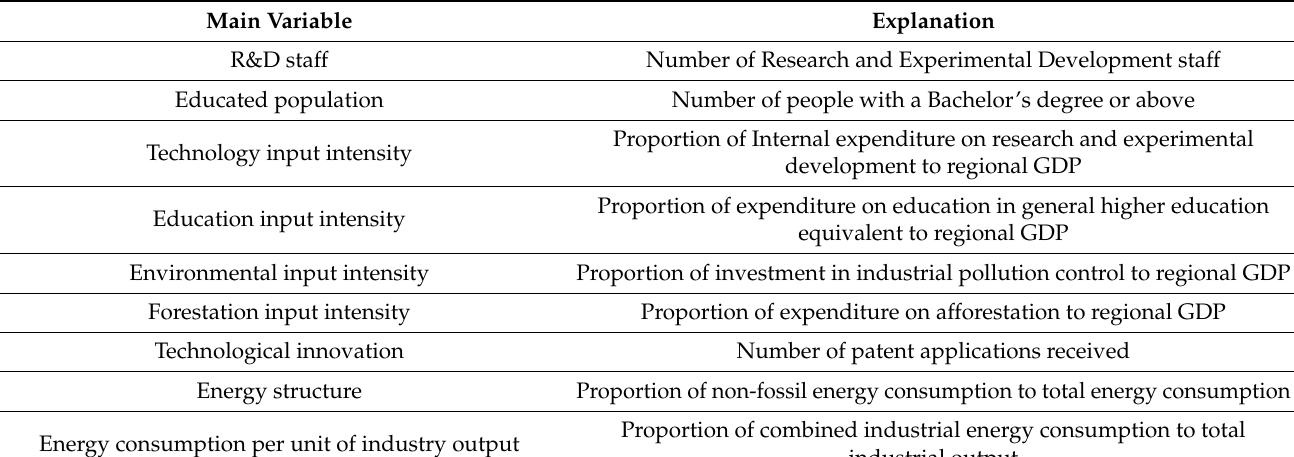
Table 3. Description of main variables of the